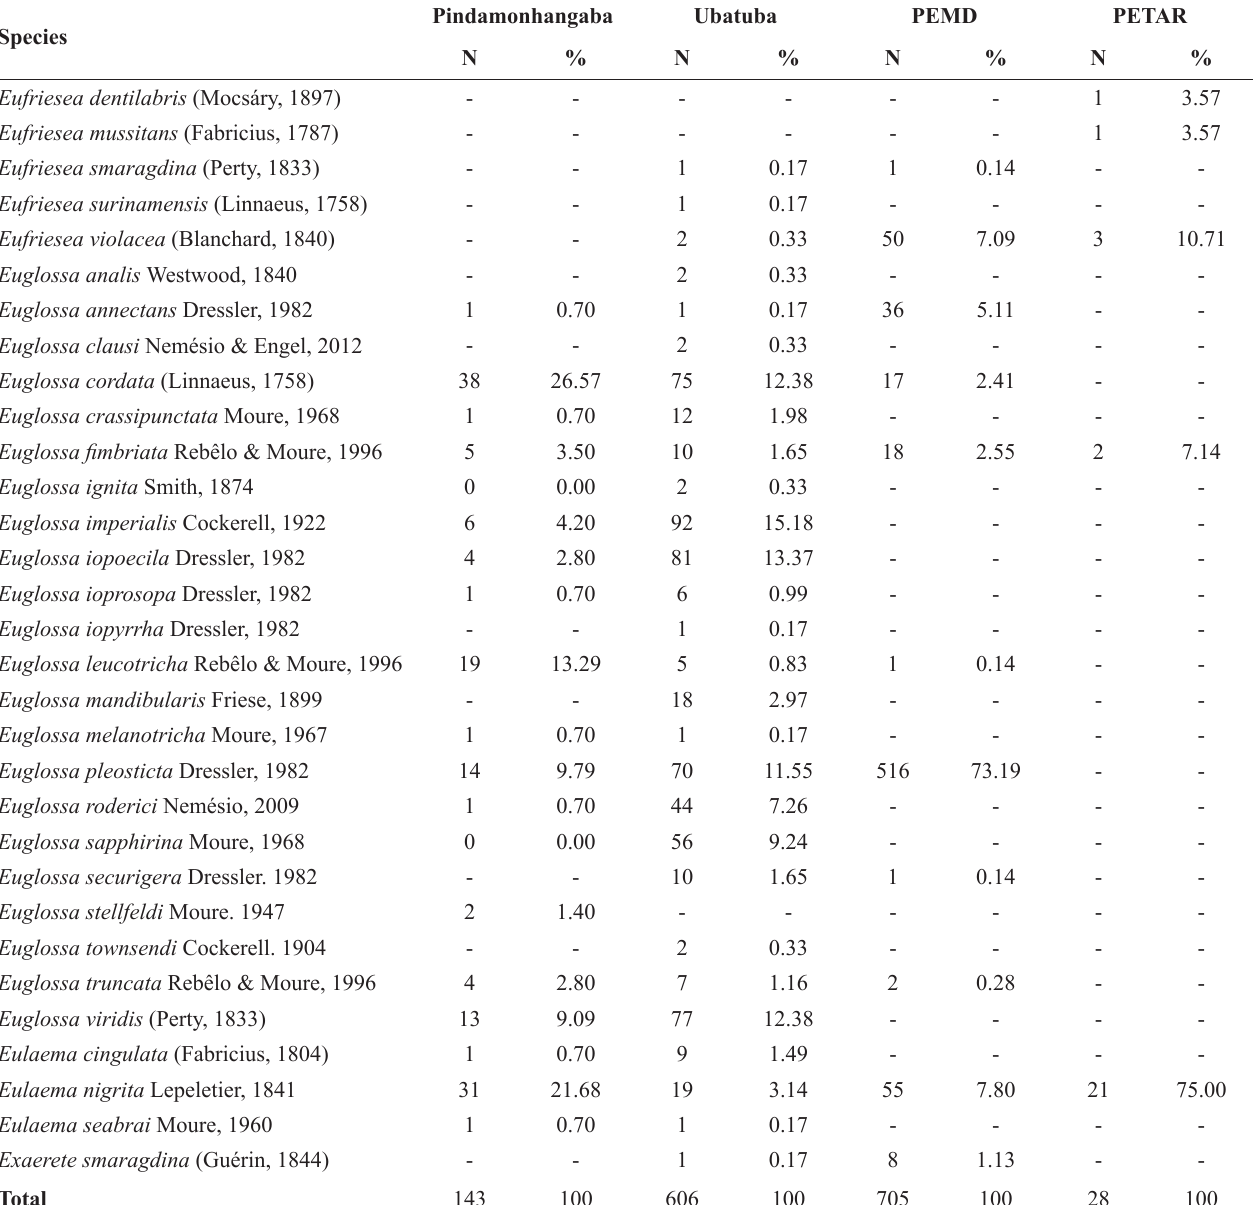
Table 1. Euglossine bees collected in different sampling sites of the Atlantic Forest at São Paulo State, Brazil. PEMD: Parque Estadual Morro do Diabo; PETAR: Parque Estadual Turístico do Alto